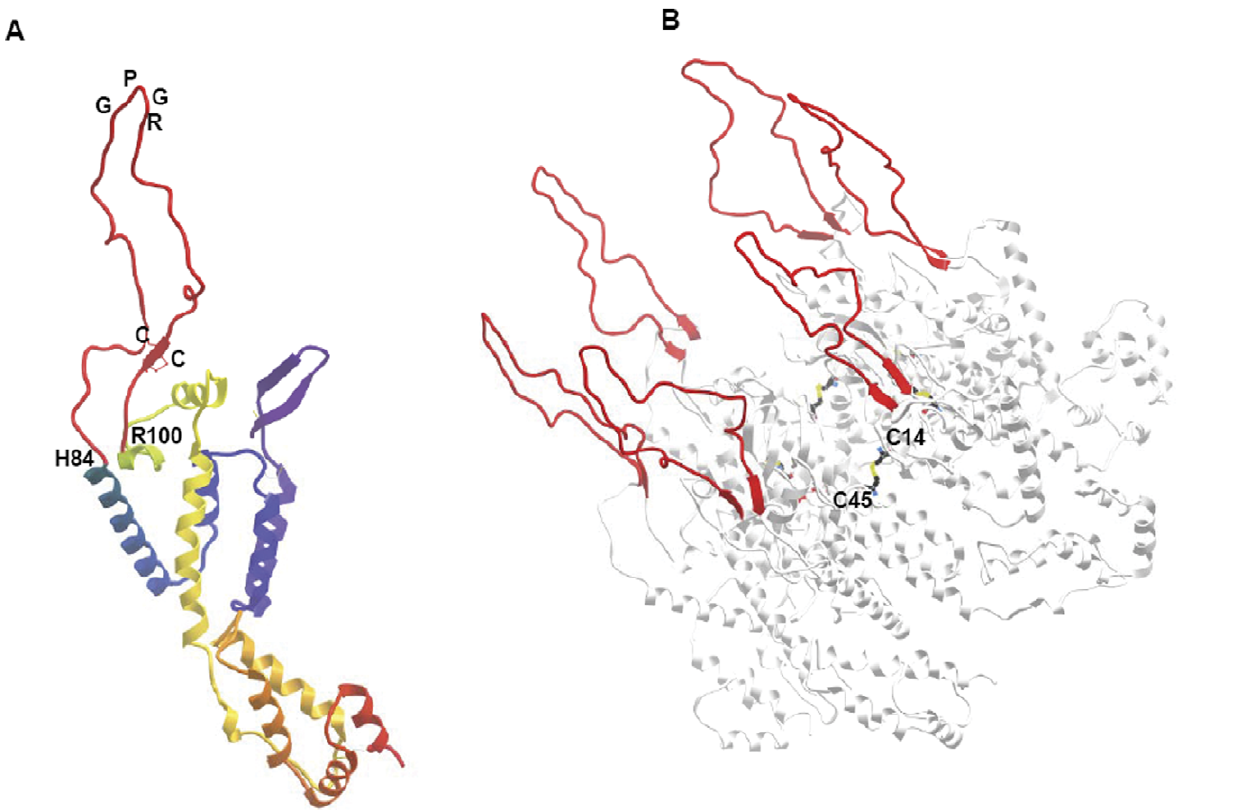
Figure 3. Display of the V3 loop by the p24 scaffold. The conformation of the V3 loop sequence inserted in the p24 CA protein within the residues H84 and R100 is shown as monomer ( A ) and as hexameric structure ( B ). The mutated cysteins in position 14 and 45 of two adjacent p24 CA monomers are indicated in the hexamer ( B ).